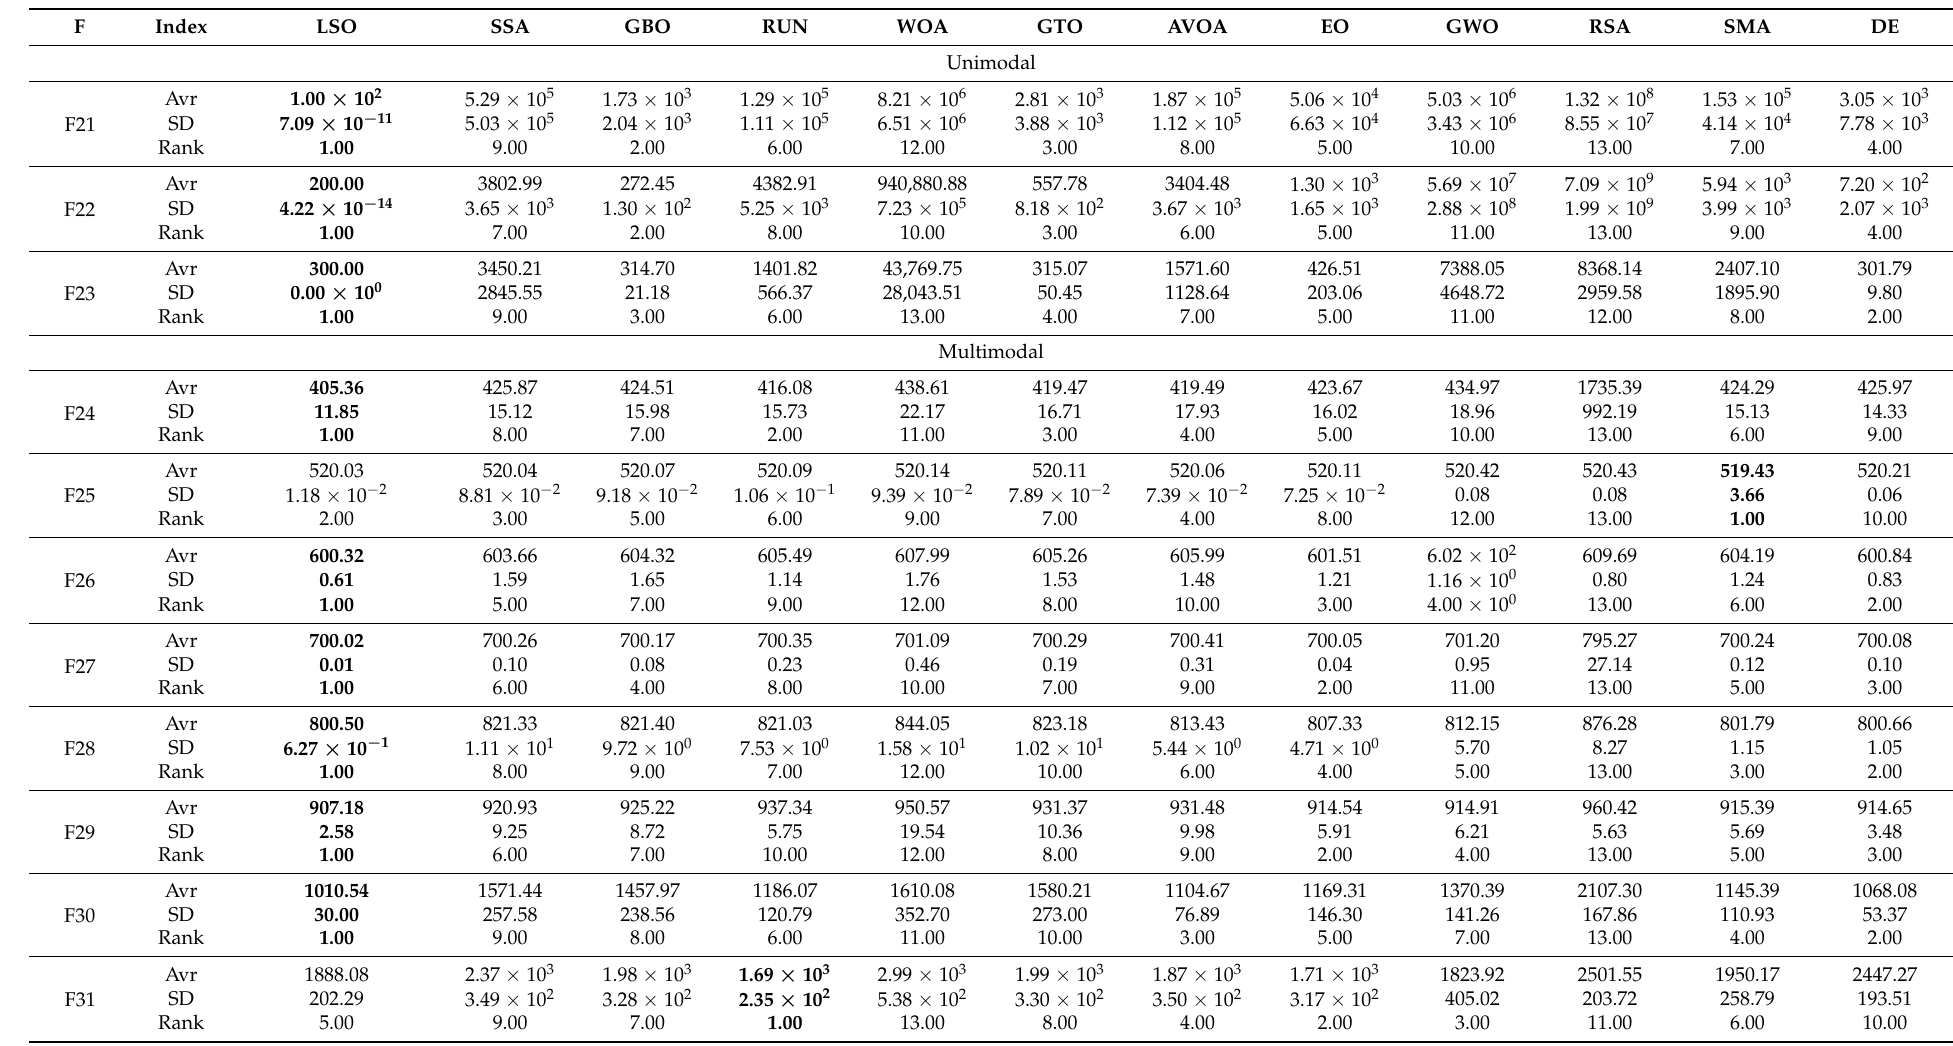
Table 8. Avr and SD of CEC2014 for 25 independent runs (The bolded value is the best